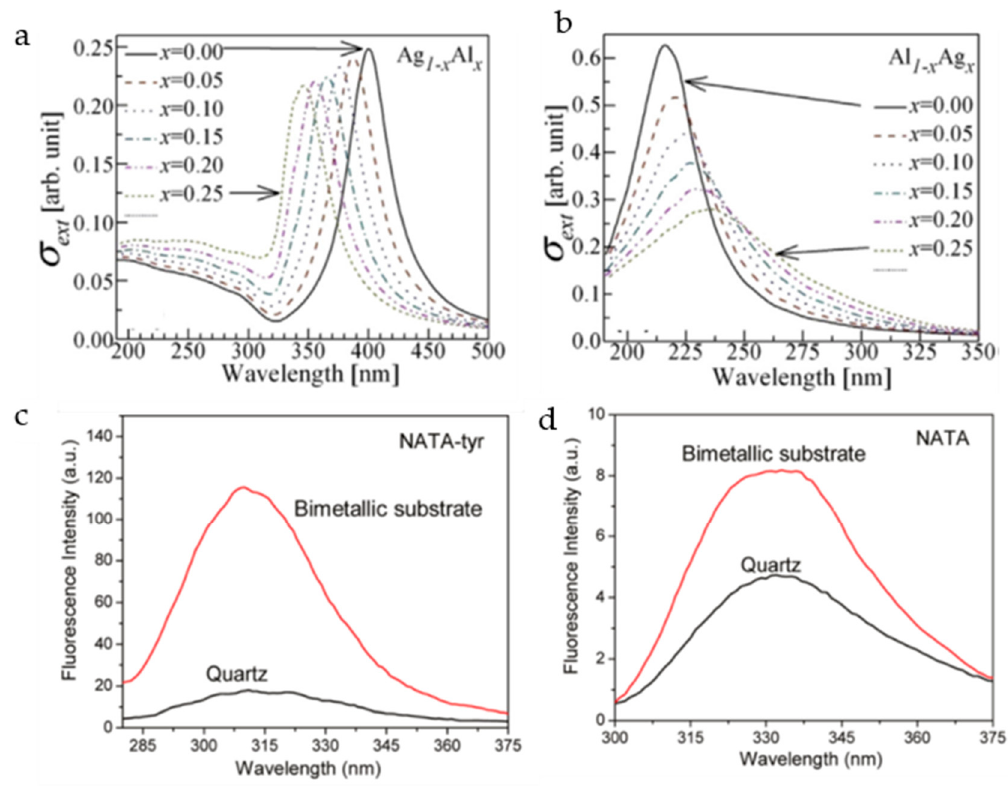
Figure 7. Extinction spectra of Ag 1 − x Al x and Al 1 − x Ag x alloys for varying molar concentrations of Al: ( a ) With increasing concentration of Al, the SPR peak blueshifts from the elemental Ag NP. ( b ) SPR peak redshifts from the elemental Al NP with increasing concentration of Ag. (Adapted from Kuiri [224]). ( c , d ) Fluorescence enhancement of NATA-tyr and NATA on quartz and bimetallic substrates. (Adapted from Chowdhury et al. [225]).